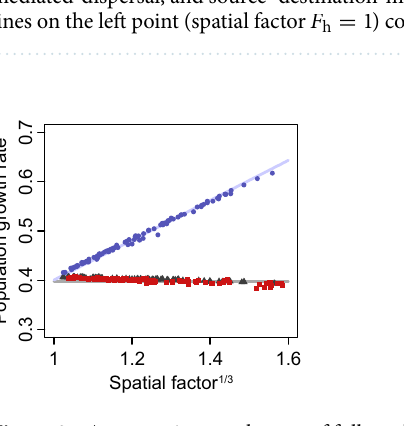
Figure 3. Asymptotic growth rates of full models increase with increases in the spatial factor, while other rates are invariant of the factor. Gray triangles, red squares, and blue circles indicate asymptotic growth rates estimated from realizations with source-mediated-dispersal, destination-mediated-dispersal, and source– destination-mediated-dispersal models, respectively. The open circle at a unit spatial factor represents a model without any spatial heterogeneities. Solid lines indicate theoretical growth rates with (blue) and without (gray) influence of spatial